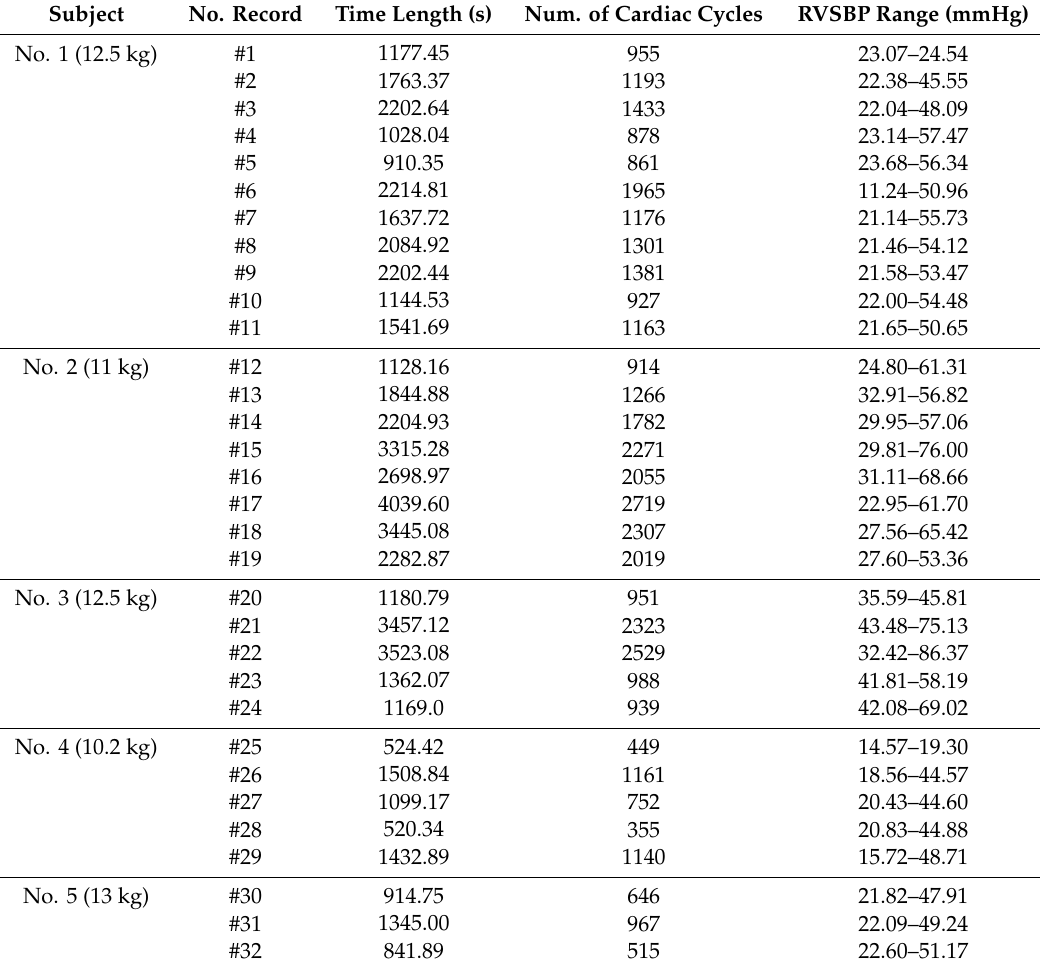
Figure 2. An example of synchronously collected signals in a record. Only typical segments were shown here; ( a ) were the ECG signals; ( b ) were the heart sound (HS) signals; ( c ) were the right ventricular blood pressure (RVBP) signals. Table 1. Summary of the data.